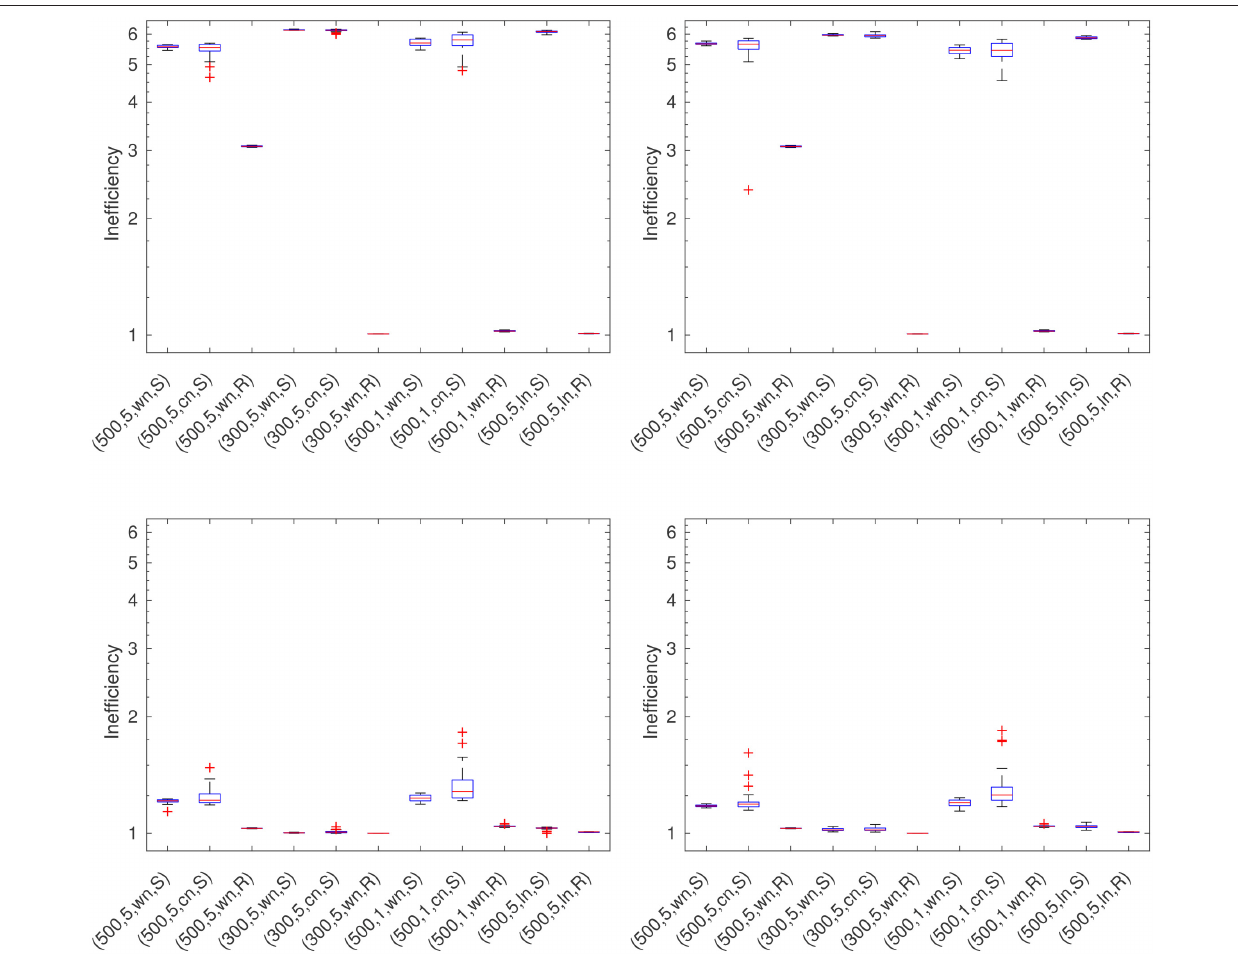
λ 1 1 to λ 100 10 − 14 and a logarithmically equal spacing = =